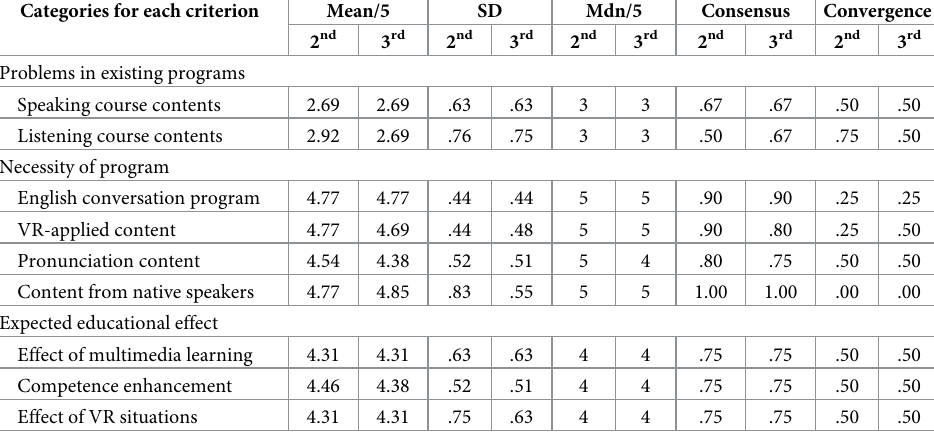
Table 5. Level of agreement with the appropriateness of the questions (second and third Delphi survey results).